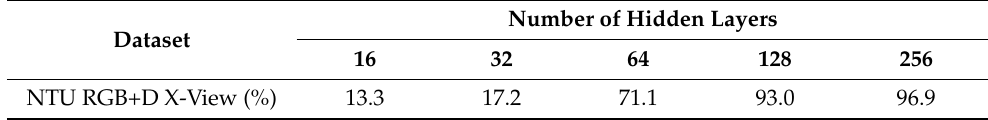
Table 8. Top 1 accuracy from various numbers of hidden